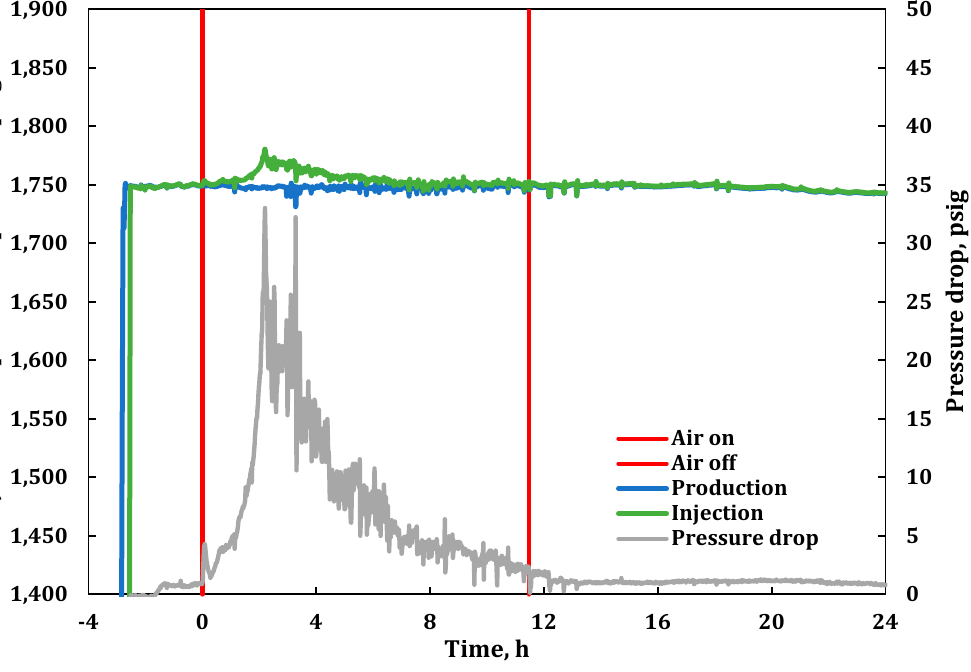
Figure 7. Pressure profile for Vuggy CT test.